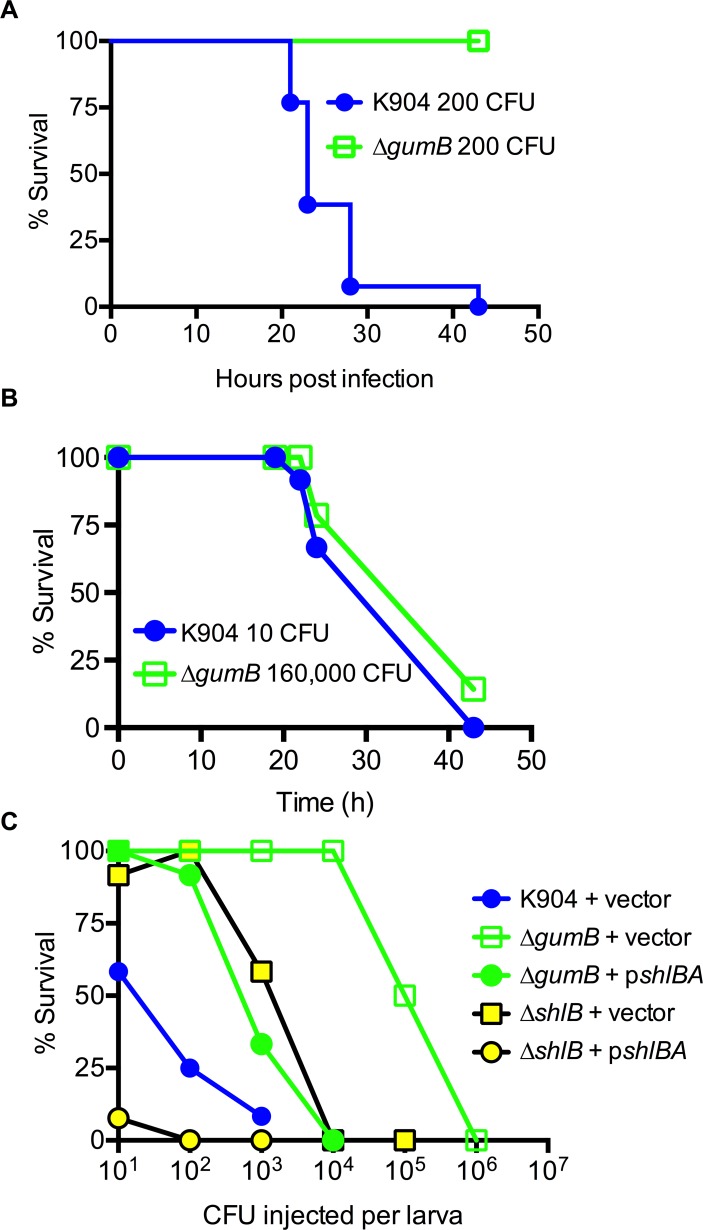
GumB is necessary for virulence in a Galleria mellonella model of infection via regulation of shlBA.Shown are survival curves of G. mellonella larvae challenged with S. marcescens. (A) G. mellonella survival over time following injection with 200 CFU is shown (n = 12 for K904, n = 13 for ΔgumB); p<0.001 Log-rank test. (B) Similar survival curves for G. mellonella over time were observed after treatment with either K904 or ΔgumB despite large differences in CFUs injected (n = 14). (C) Survival of larvae injected with the ΔgumB mutant and ΔshlB plasmid with various plasmids as indicated (n = ≥12). Vector = pMQ125; pshlBA = pMQ541.